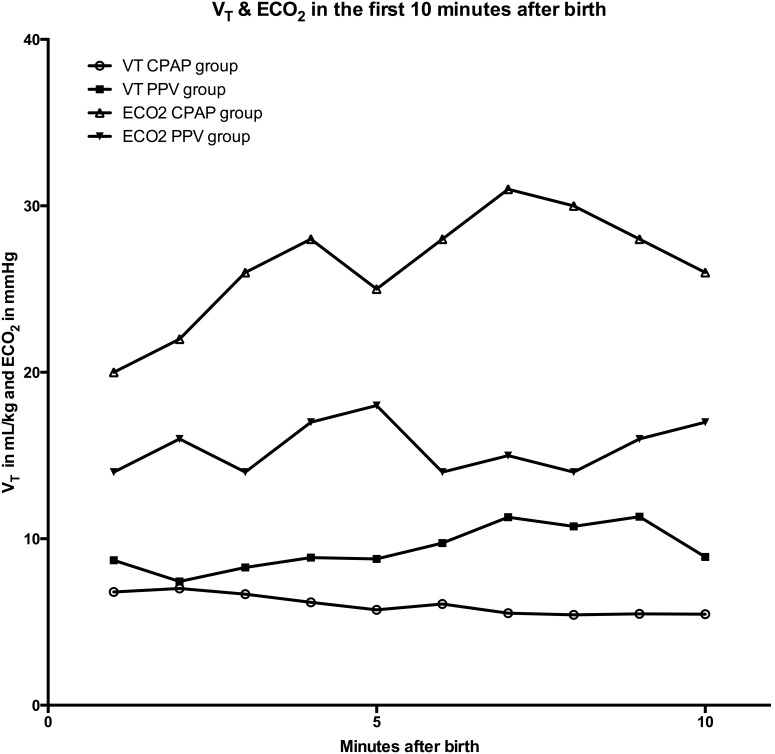
Tidal volume (VT) and exhaled CO2 (ECO2) during positive pressure ventilation (PPV) and in infants who are supported with continuous positive airway pressure (CPAP).